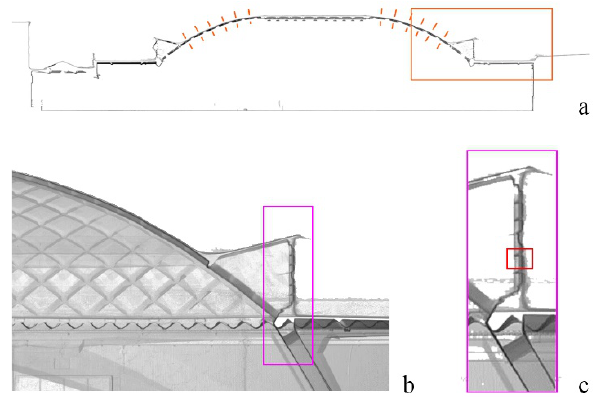
Figure 11 . Longitudinal section of the integrated 3D model (LiDAR+UAV) (a), with a zoomed view (b) of the vaulted system node and the perimeter skylights (b).